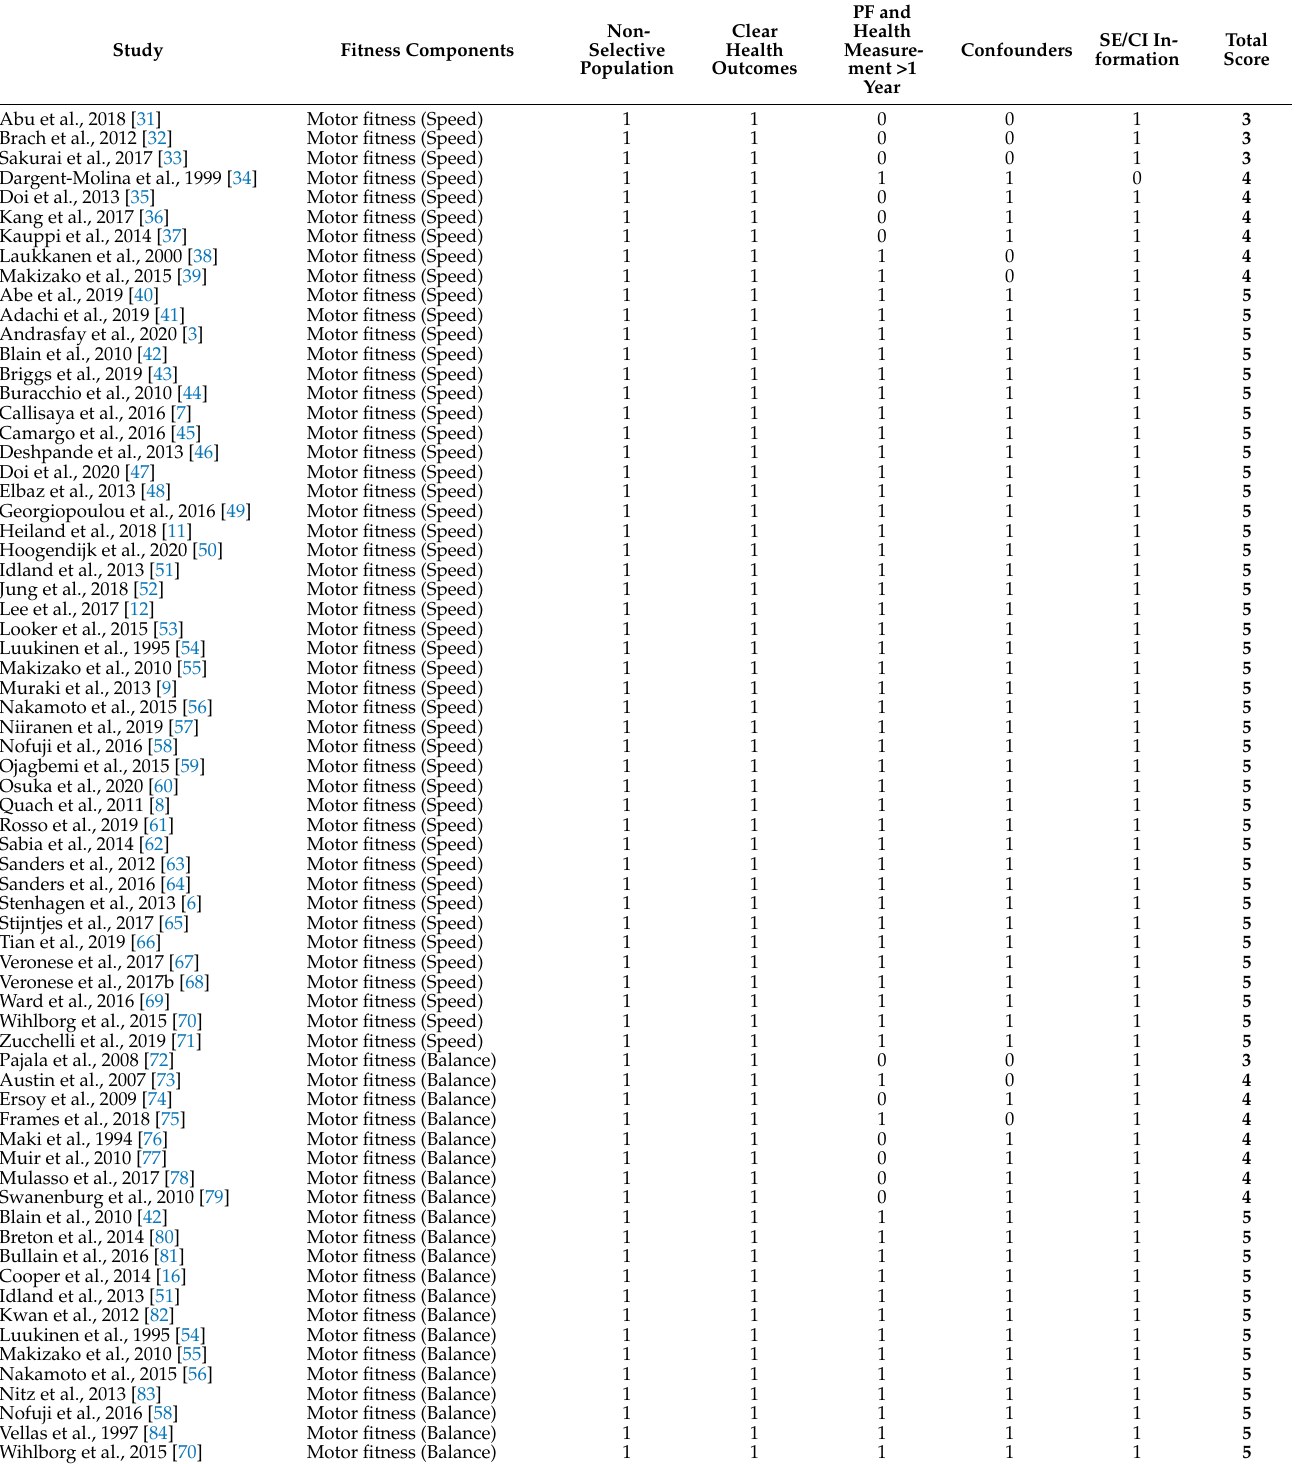
Table 1. List of included longitudinal studies with quality scores with reference to predictive value of motor fitness and flexibility tests for health outcomes in adults and older